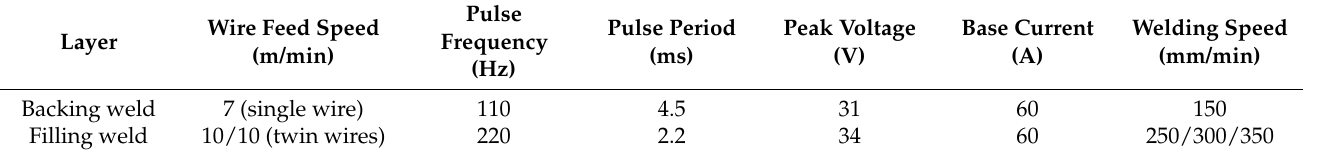
Table 3. Welding parameters.